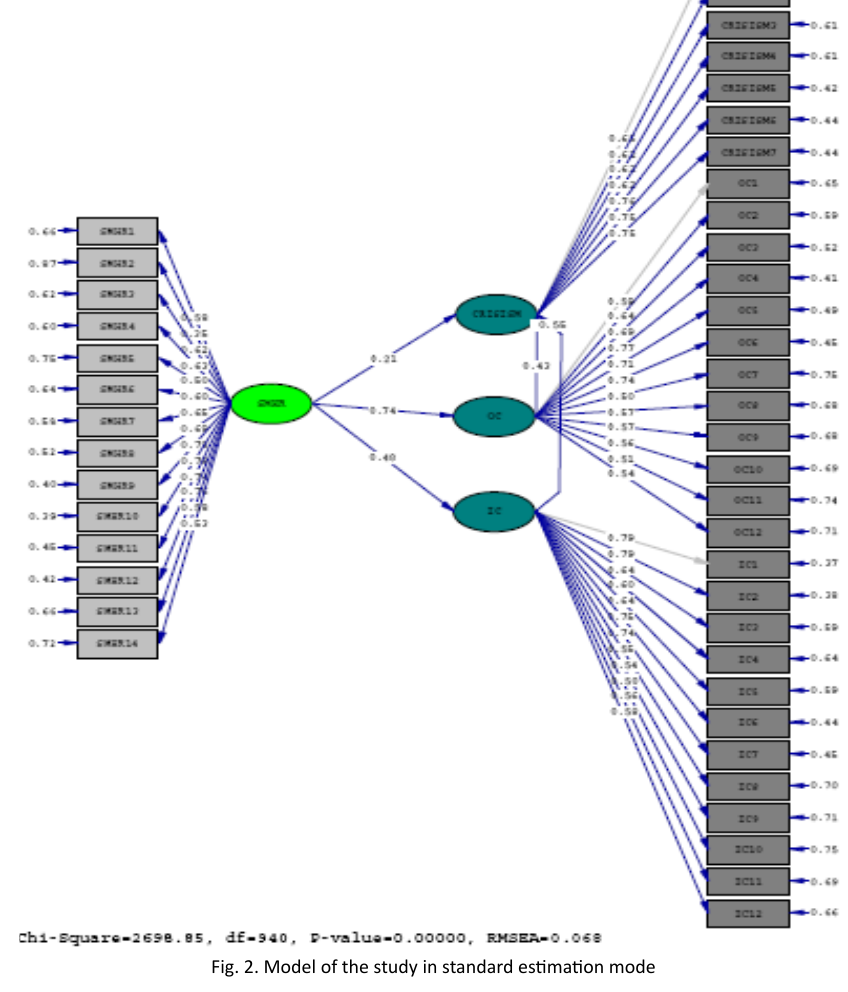
Fig. 2. Model of the study in standard estimation Fig. 2: Model of the study in standard estimation mode